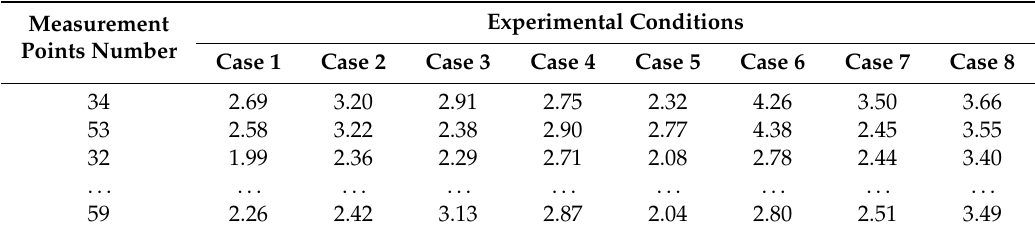
Experimental Conditions